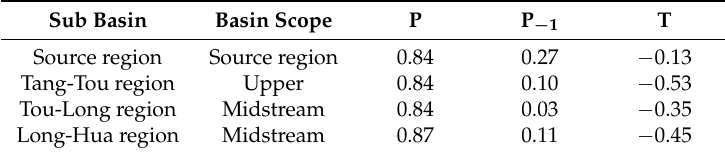
Table 3. The correlation coefficient of each element to annual streamflow in four regions of the YRB.